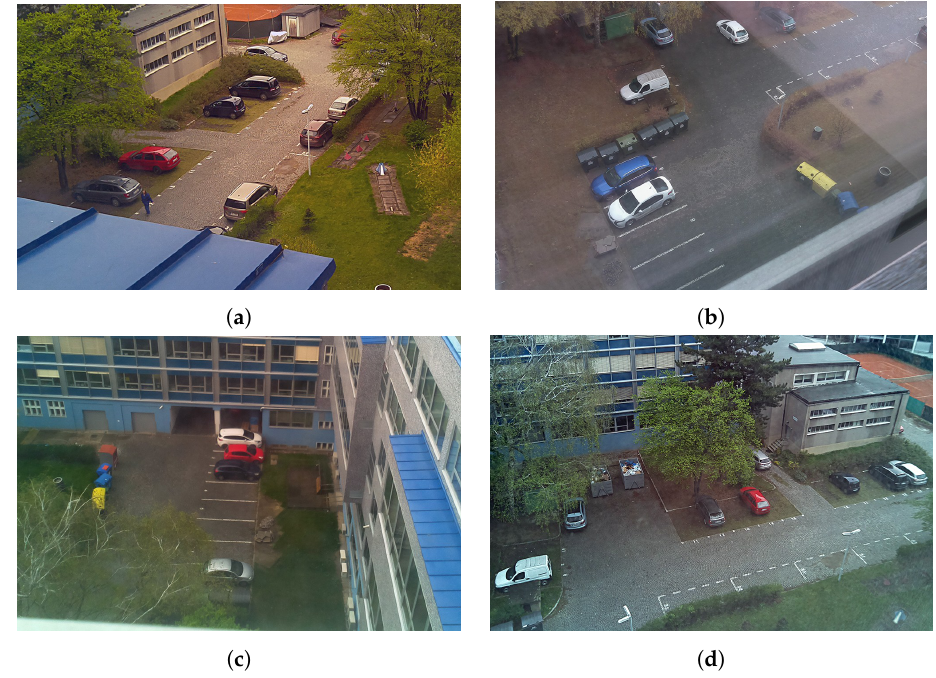
Figure 10. FELSlot dataset ( a ) Position A1–14 parking slots, 1615 images; ( b ) Position A1–14 parking slots, 695 images; ( c ) Position B1–8 parking slots, 1635 images; ( d ) Position B2–16 parking slots, 1604 images.